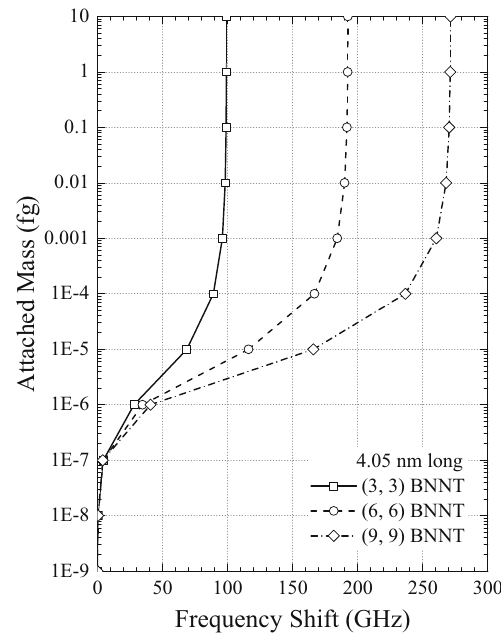
Figure 4: Frequency shifts for ( 3,3 ) , ( 6,6 ) , and ( 9,9 ) cantilevered SW - BNNT with length 4.05 nm for di ff erent attached